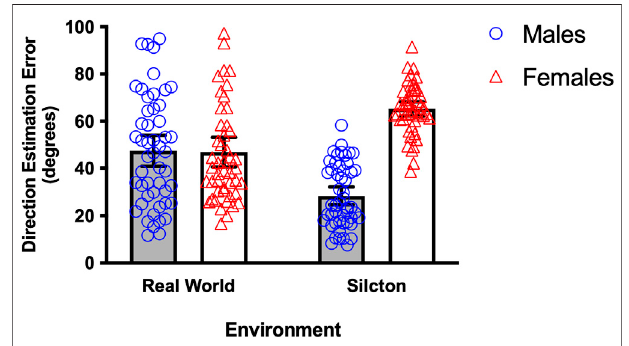
FIGURE 2 | Direction estimation error means and individual scores for women and men estimating directions between landmarks in Silcton and the real-world locations they provided in Experiment 1. Horizontal scatter of the individual scores corresponds to the number of scores at that value (wider = more scores). Error bars show 95% con fi dence intervals.